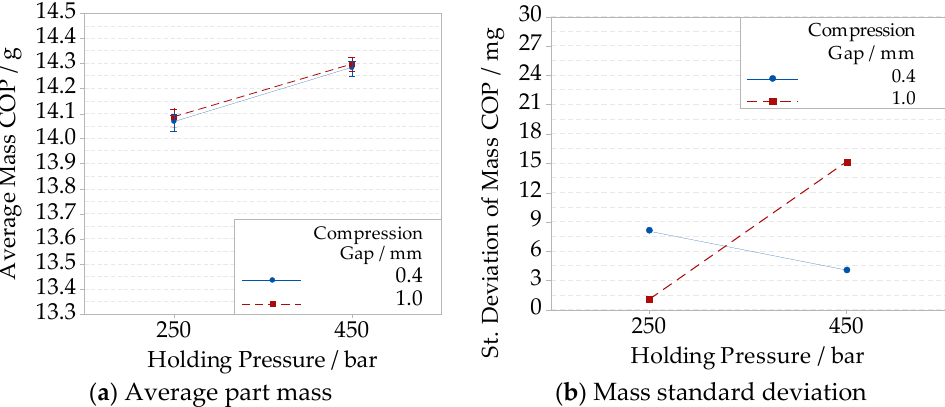
Figure 15. Interaction plots showing for the COP material, and different compression gap and holding pressure levels combinations: ( a ) average part mass; ( b ) mass standard deviation. During compression, the action on the polymer inside the cavity works as an in-thickness